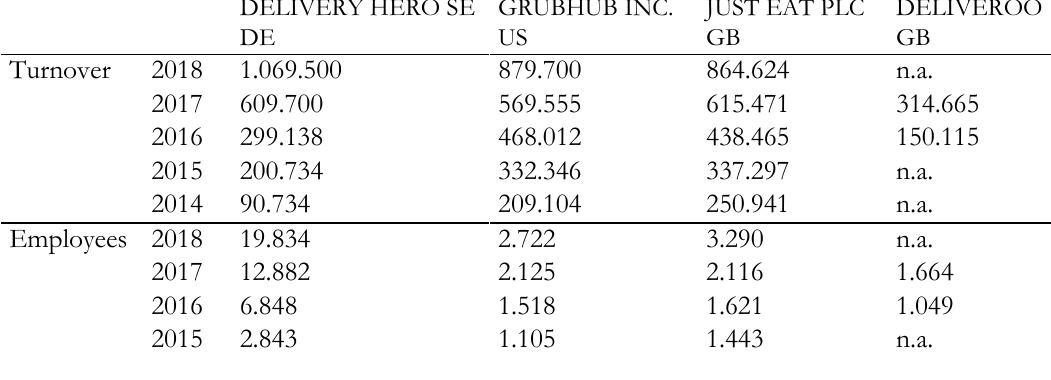
Table 3 – Financial Statements data of some food delivery players (thousands of